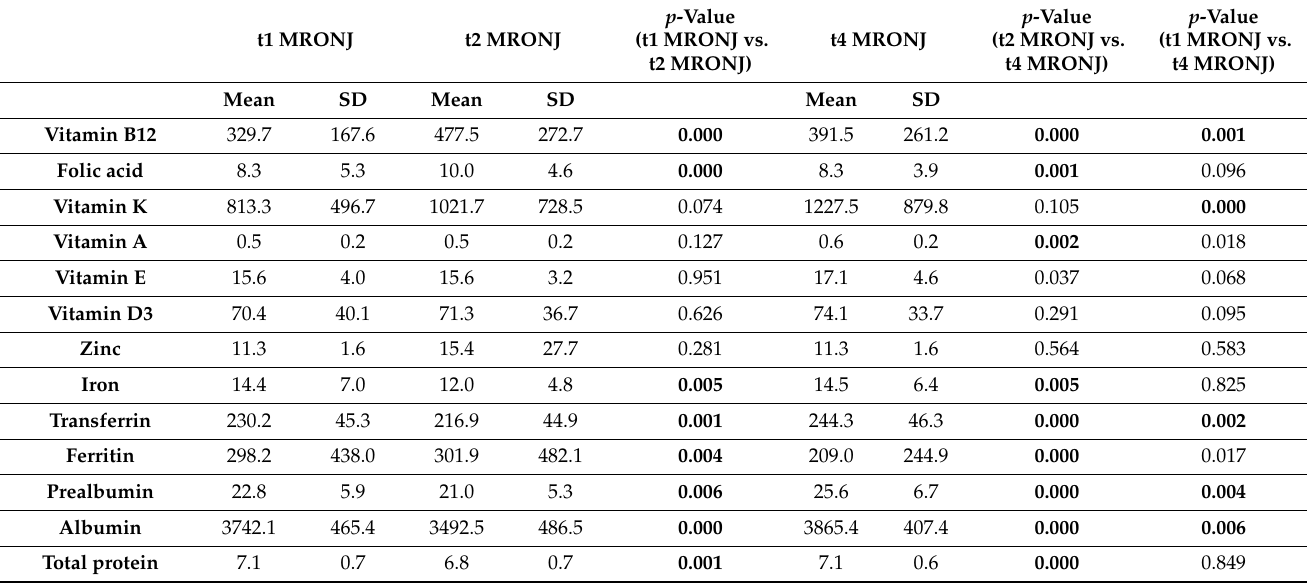
Table 8. Blood serum values of vitamins, proteins, and micronutrients at different points in time (t1, t2, t4). p -values < 0.017 are statistically